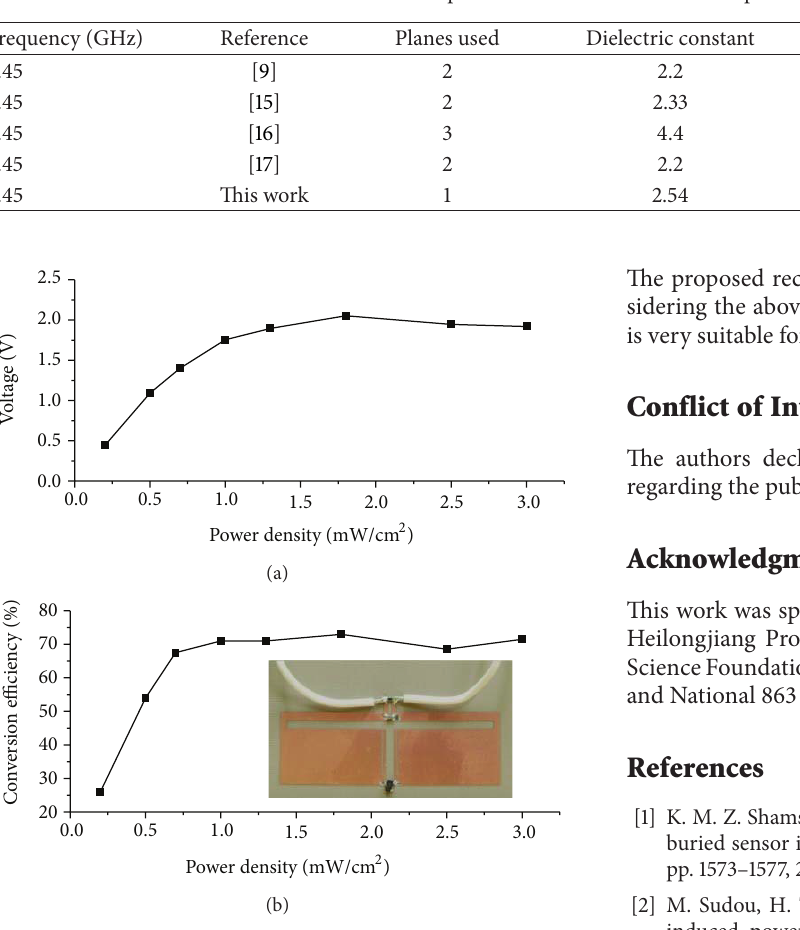
Table 3: Comparison of this work with several published work.